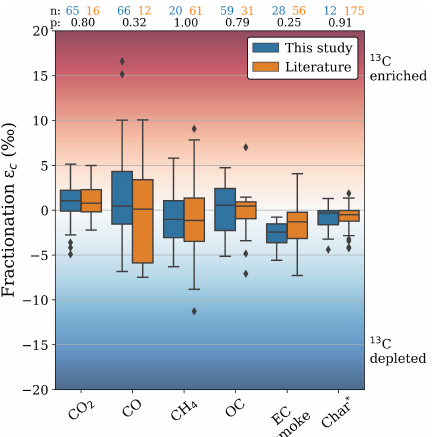
Figure 6. δ 13 C fractionation in burning products from this study (blue) and the previous literature (orange). The numbers above the boxplots (n) and (p) represent the number of individual δ 13 C mea- surements and the P value calculated using a two-tailed t test with unequal variance, respectively. The literature “char” fraction was compared to the “residual” fraction in this